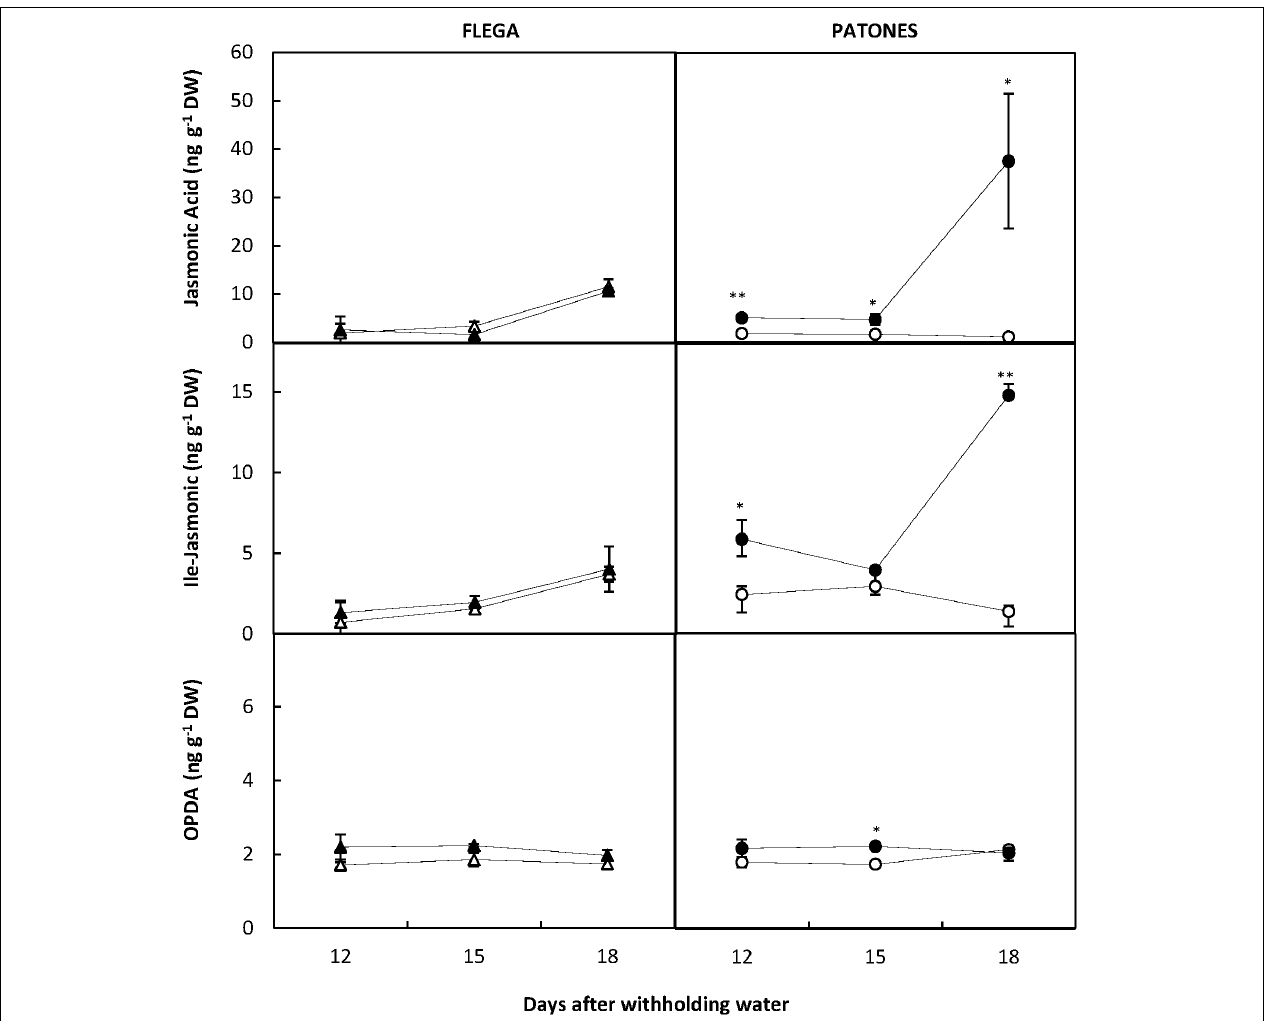
FIGURE 9 | Jasmonate content during a drought time course. Jasmonic acid, Ile-jasmonic and OPDA were quantified in drought susceptible Flega (triangles) and resistant Patones (circles) well-watered plants (open symbols) and during a time course of water stress (solid symbols) (9, 12, 15, and 18 days). Data are mean of five replicates ± standard error. ∗ and ∗∗ indicate significant differences at P < 0.05 and 0.01,